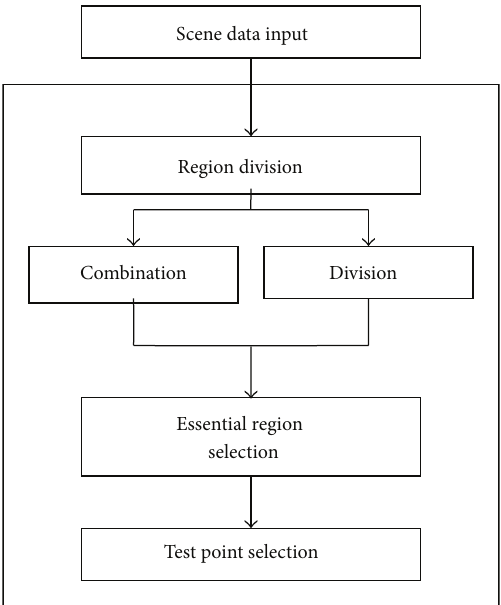
Figure 5: The process of surveillance scene discretization.